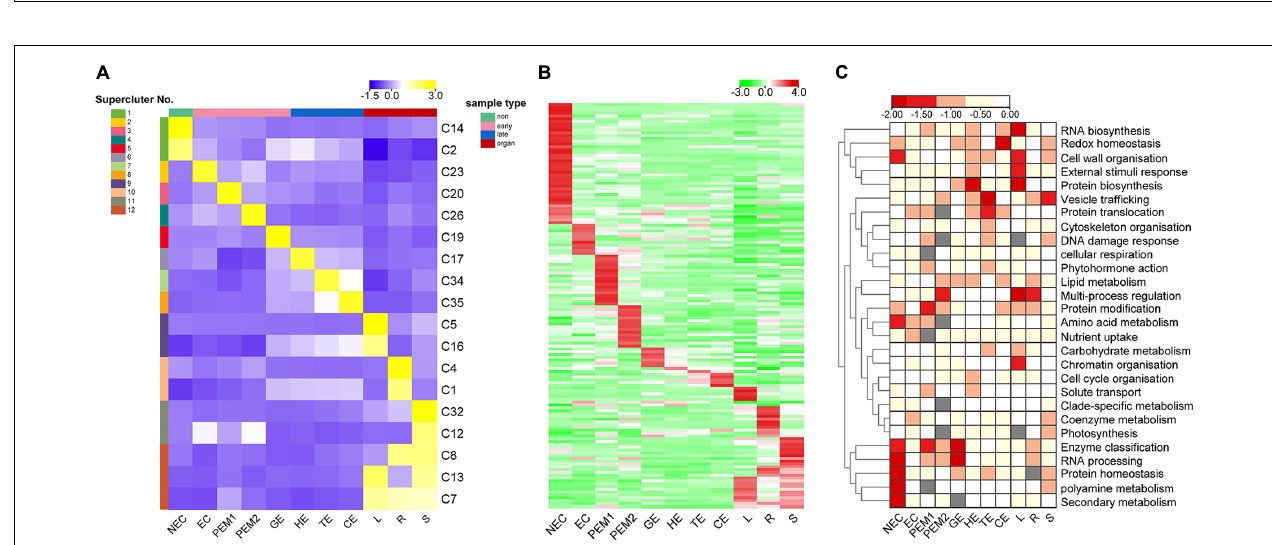
FIGURE 4 | Heatmap of the differentially expressed genes in auxin and cytokinin signaling pathway during hybrid sweetgum SE. (A) Auxin signal transduction; (B) IAA biosynthesis; (C) Zeatin biosynthesis; (D) Cytokinin signal transduction. The heatmap was clustered by pearson method of TBtools software. Heatmap indicate the gene expression level by Log2[FPKM] with a color scale, each row represents a single gene, the IDs and names of selected DEGs are indicated to the right of the histograms, and each column represents a sample.